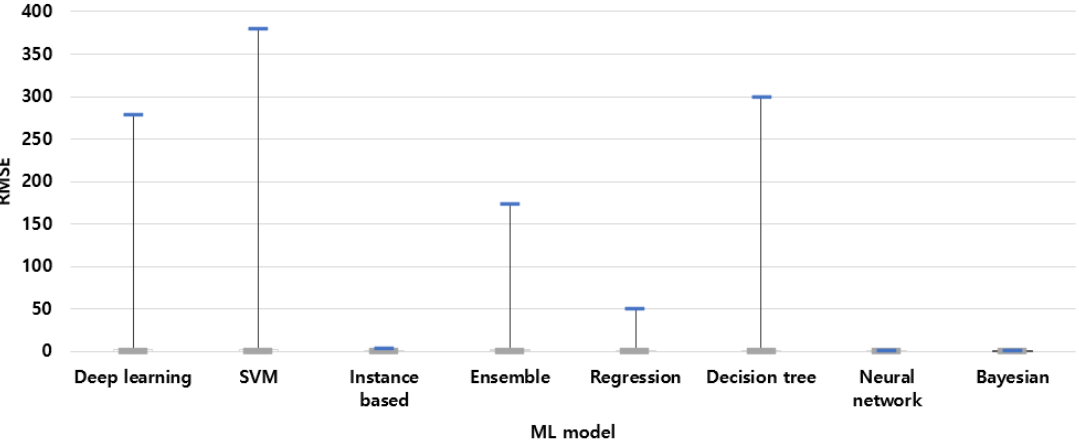
Figure 13. Box plots for RMSE.